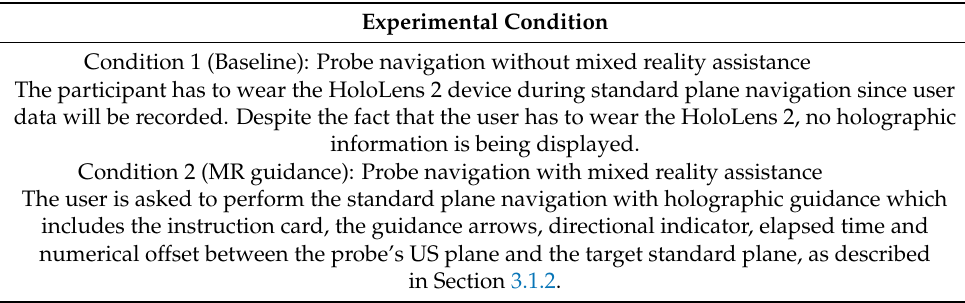
Table 2. The two experimental conditions of the user study. Experimental